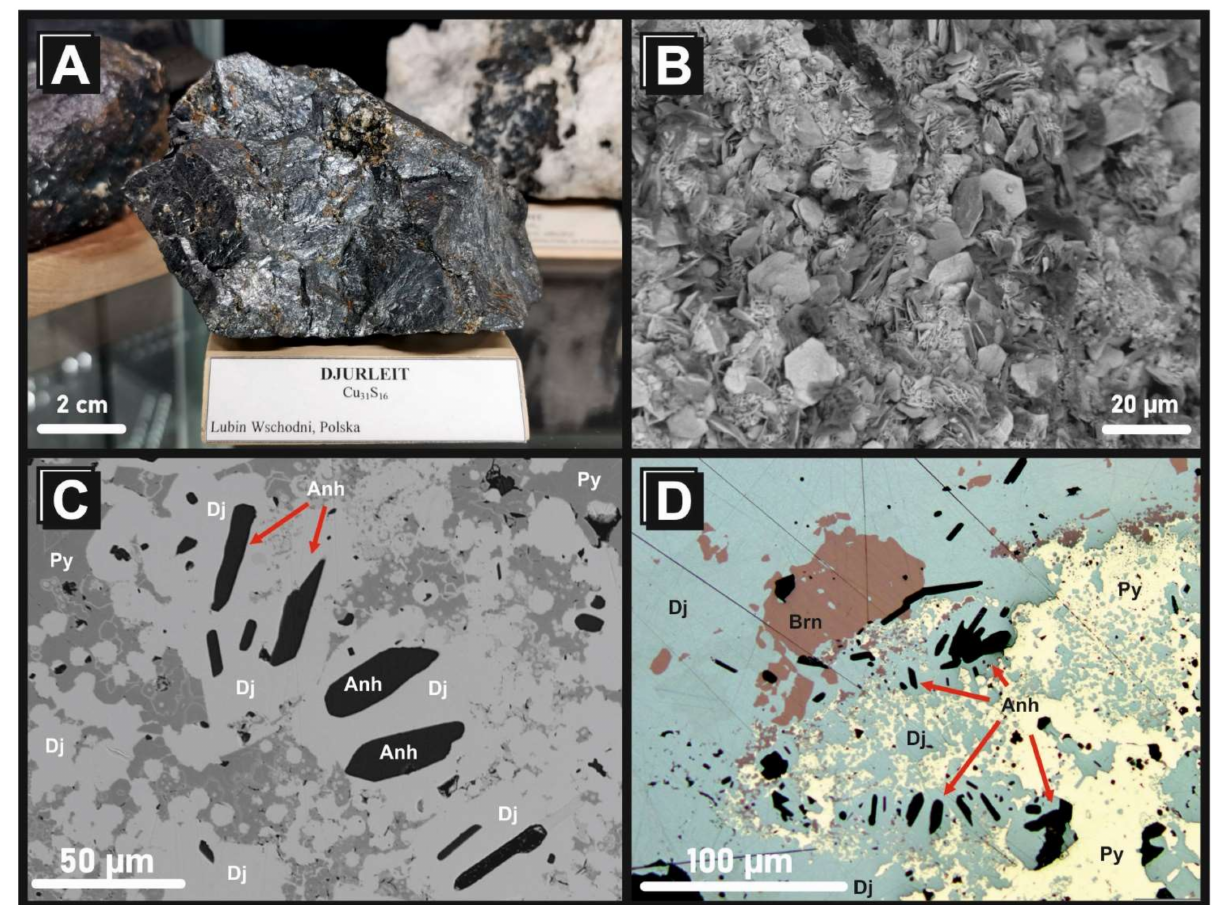
Figure 2. ( A ) Sample of the djurleite studied (previously identified as chalcocite), from the mineralogical collection of the Earth Sciences Museum, University of Silesia, Katowice, Poland. ( B ) Crystals of djurleite (back-scattered electron imaging (BSE) image) in a small cavity. ( C ) BSE image of djurleite (Dj) associated with bornite (Brn) and pyrite (Py). The dark mineral is anhydrite (Anh). ( D ) The same association in reflected